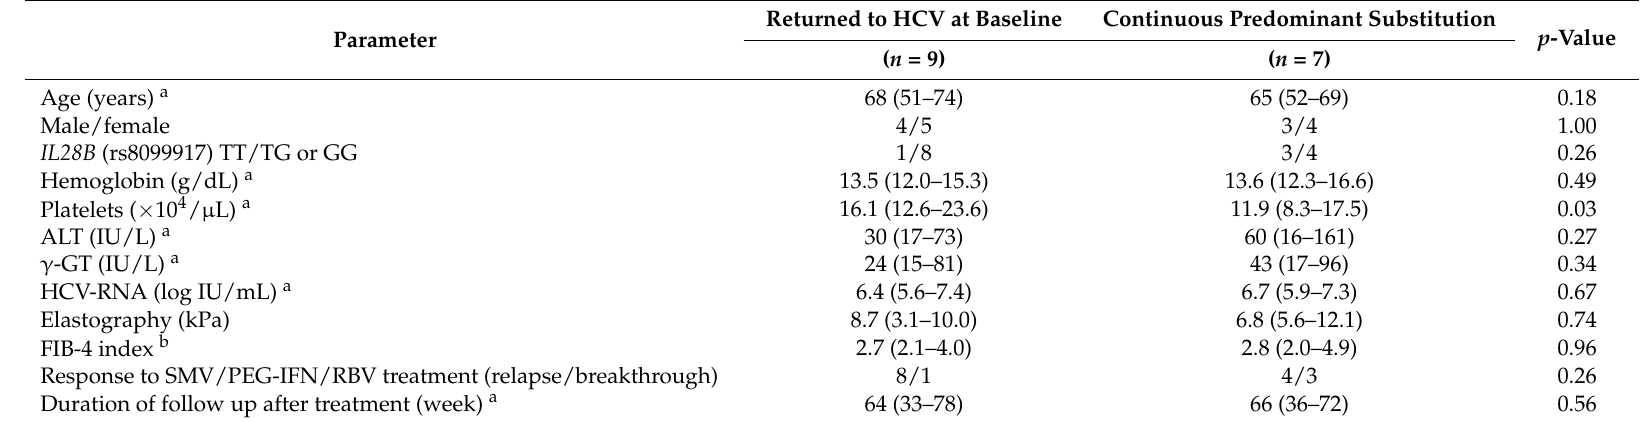
Table 1. Comparison of the two groups stratified by the change in predominance of the resistance-associated substitution (RAS) at D168 after simeprevir/pegylated- interferon/ribavirin (SMV/PEG-IFN/RBV) treatment